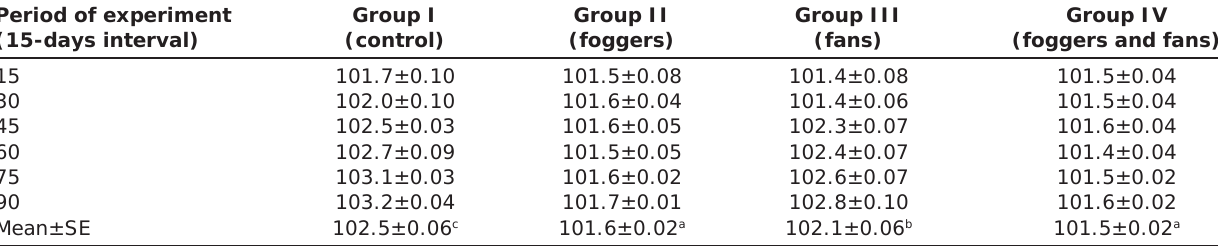
Table-6: Effect of microclimate alteration on rectal temperature (°F) in Murrah buffaloes during summer. Period of experiment (15-days